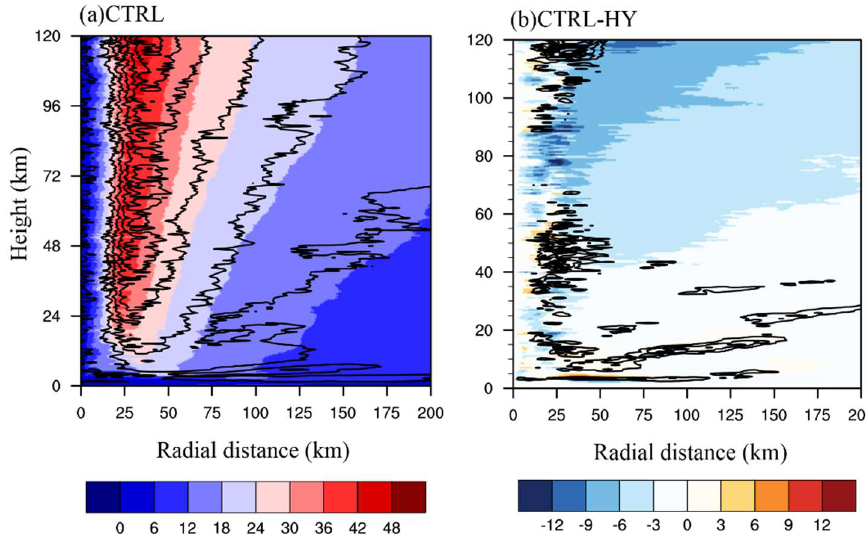
Figure 3. Time evolution of azimuthal mean 10-m tangential winds (color shaded, m s − 1 ), and radial winds (lines, m s − 1 ) for ( a ) CTRL, and ( b ) CTRL-HY (radial winds < − 2 m s − 1 ).